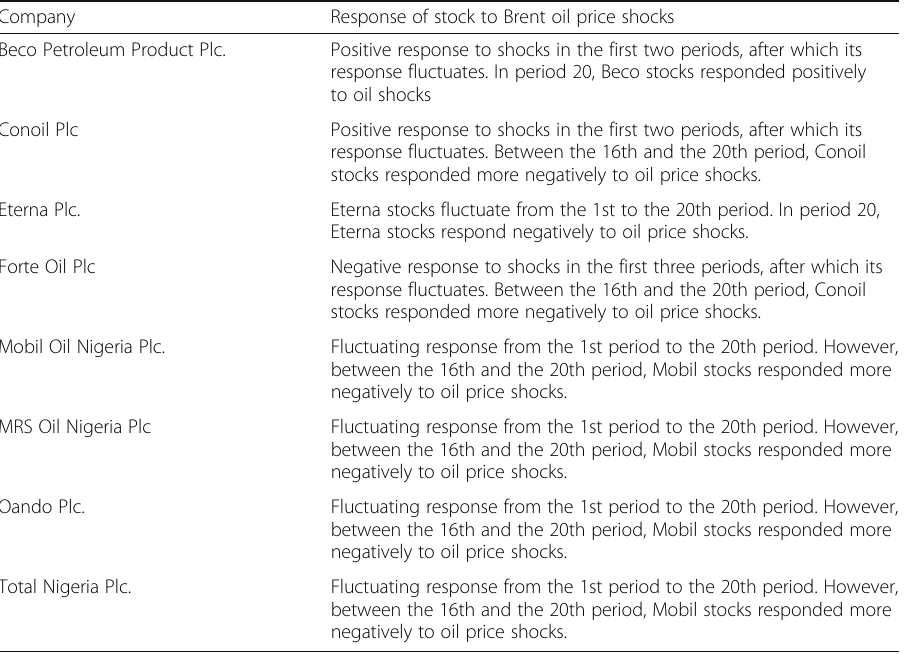
Table 3 Response of stock to Brent oil price shocks per